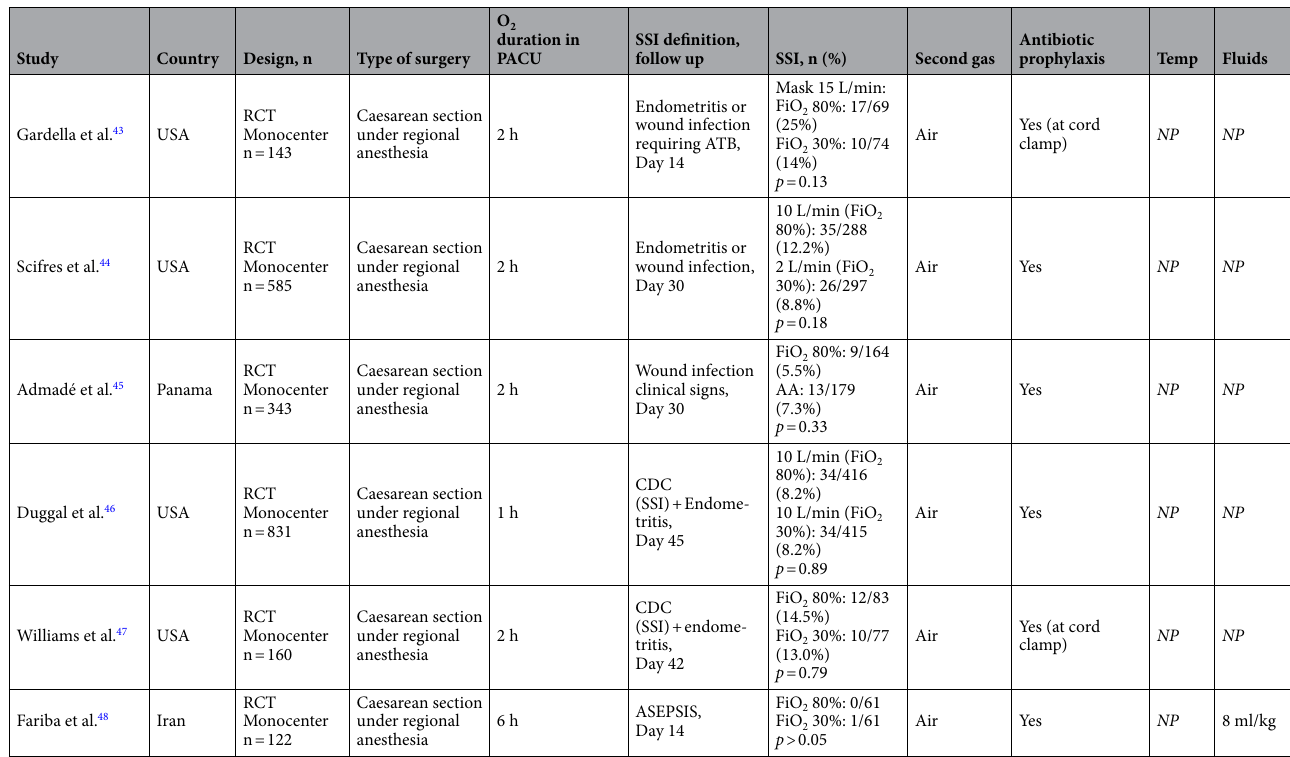
Table 2. Summary of the main characteristics and results of the studies including patients under regional anesthesia.